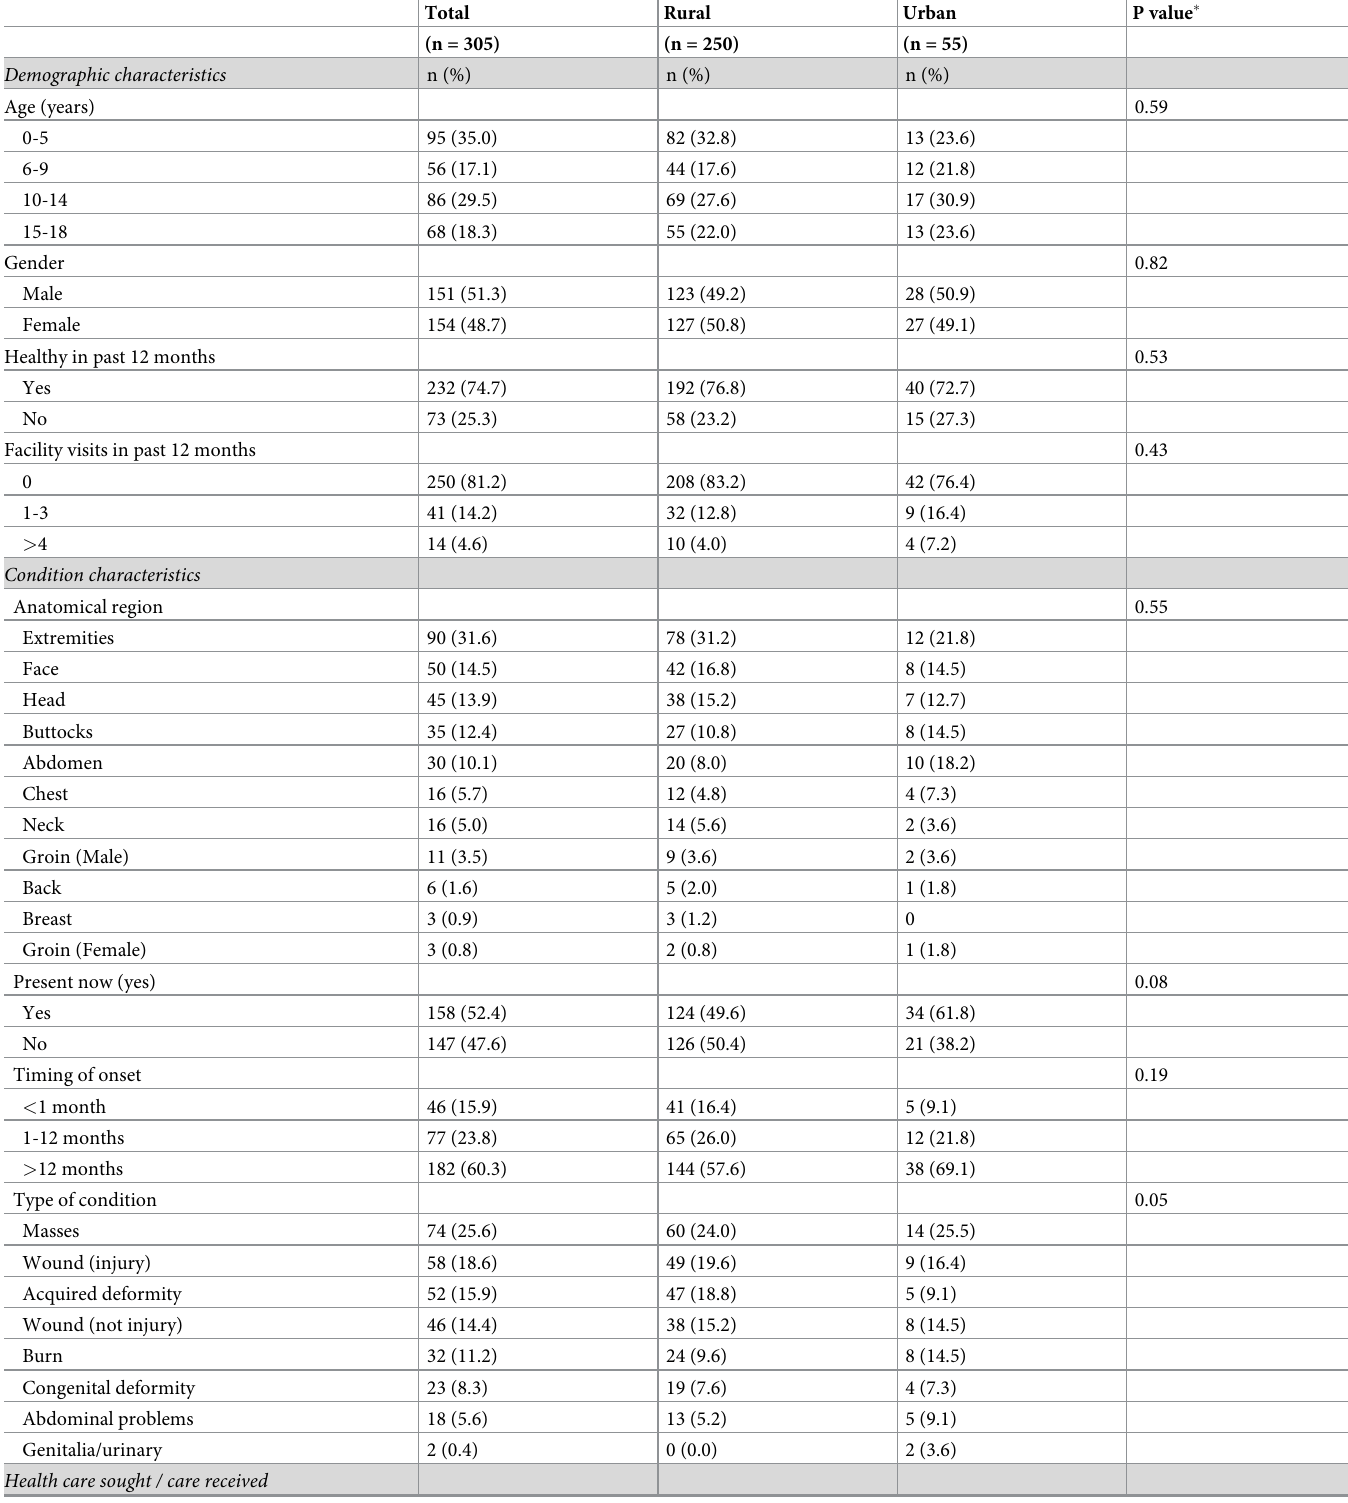
Table 1. Demographic characteristics of children with surgical needs, by location of